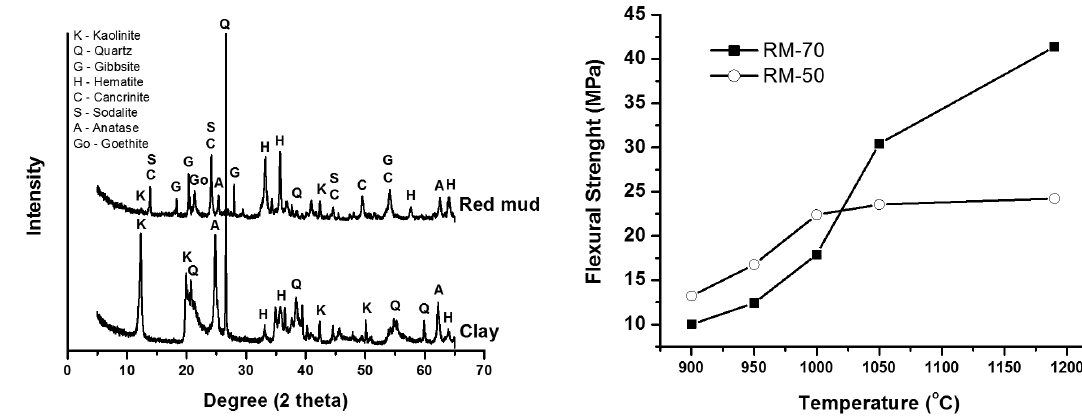
Figure 4. Flexural strength of samples RM-70 and